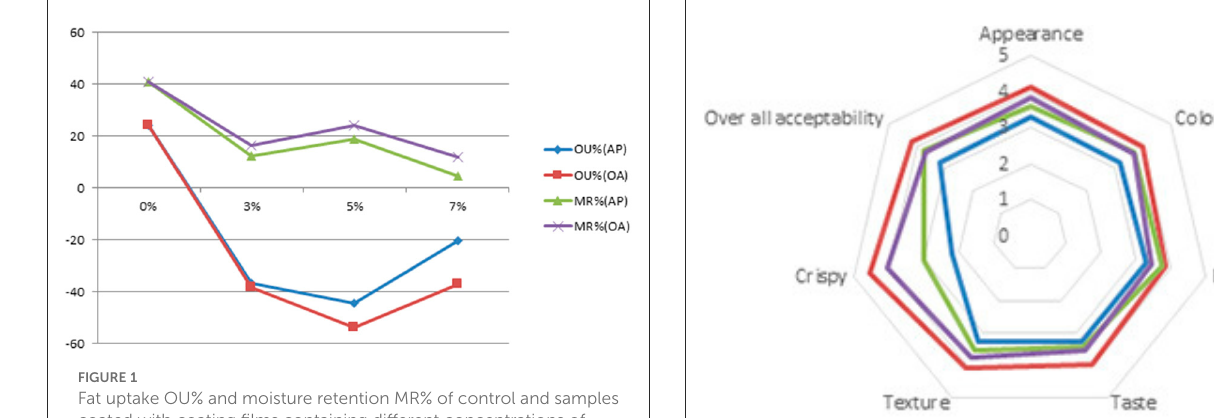
FIGURE1 Fat uptake OU% and moisture retention MR% of control and samples coated with coating films containing different concentrations of orange albedo (OA) and apple peel (AP) in the preparation of deep-fried falafel balls.